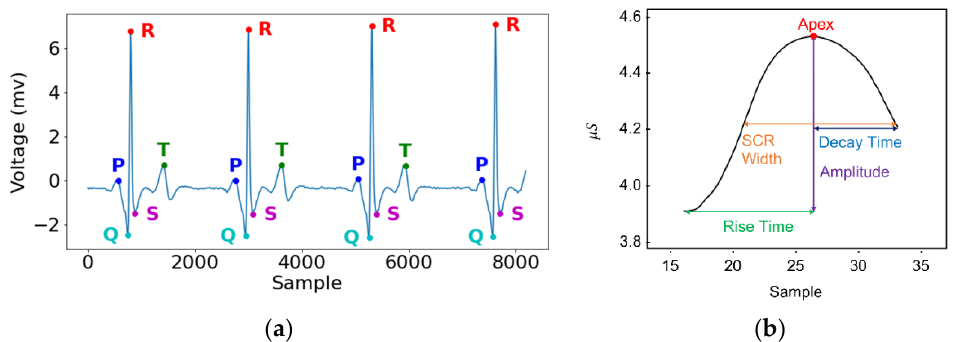
Figure 2. ( a ) Peaks in ECG signals located by the NeuroKit. ( b ) Four GSR features extracted by PySiology.